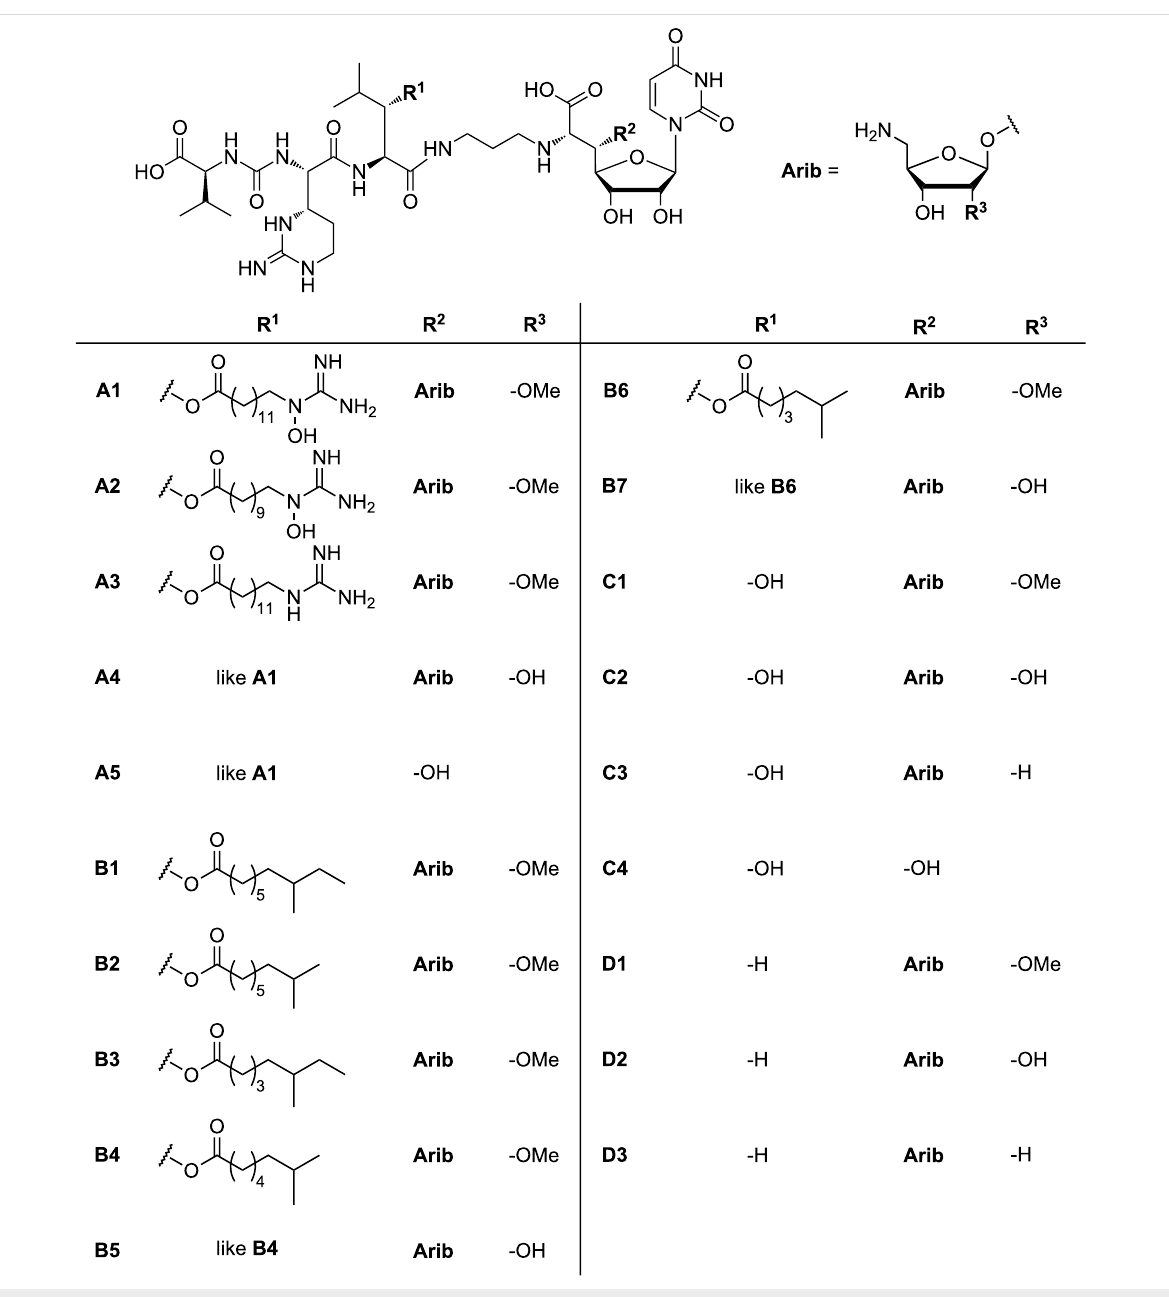
The mureidomycins [36-38] and pacidamycins [39-41], both re- ported in 1989, the napsamycins (1994) [42] and the sansan- mycins (2007) [43,44] are structurally closely related. They consist of a 3'-deoxyuridine unit with a unique enamide linkage and the non-proteinogenic N -methyl-2,3-diaminobutyric acid, which branches into two peptide moieties. They differ in the amino acid residues AA 2 , AA 4 and AA 5 , with AA 2 and AA 5 being aromatic in all four classes. The amino acid residue AA 4 is either methionine for mureidomycins, napsamycins